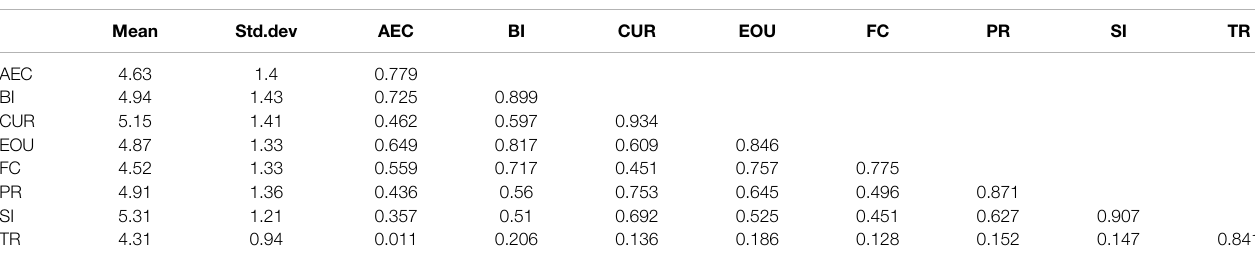
TABLE 3 | Discriminant validity (Fornell-Larcker Criterion). Mean Std.dev AEC